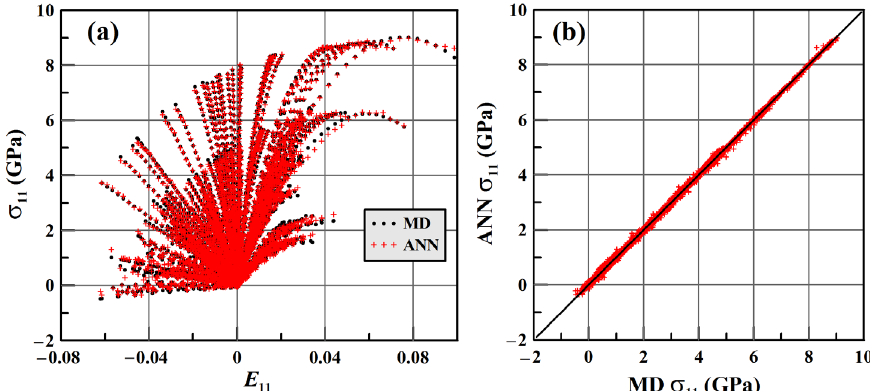
Figure 5. The results of ANN training for the tensor equation of state for nanoporous aluminum: ( a ) superposition of MD and ANN data for the longitudinal stress σ 11 plotted versus the longitudinal deformation E 11 ; ( b ) correlation between the MD and the ANN for σ 11 ; the coefficient of determination is R 2 = 79%